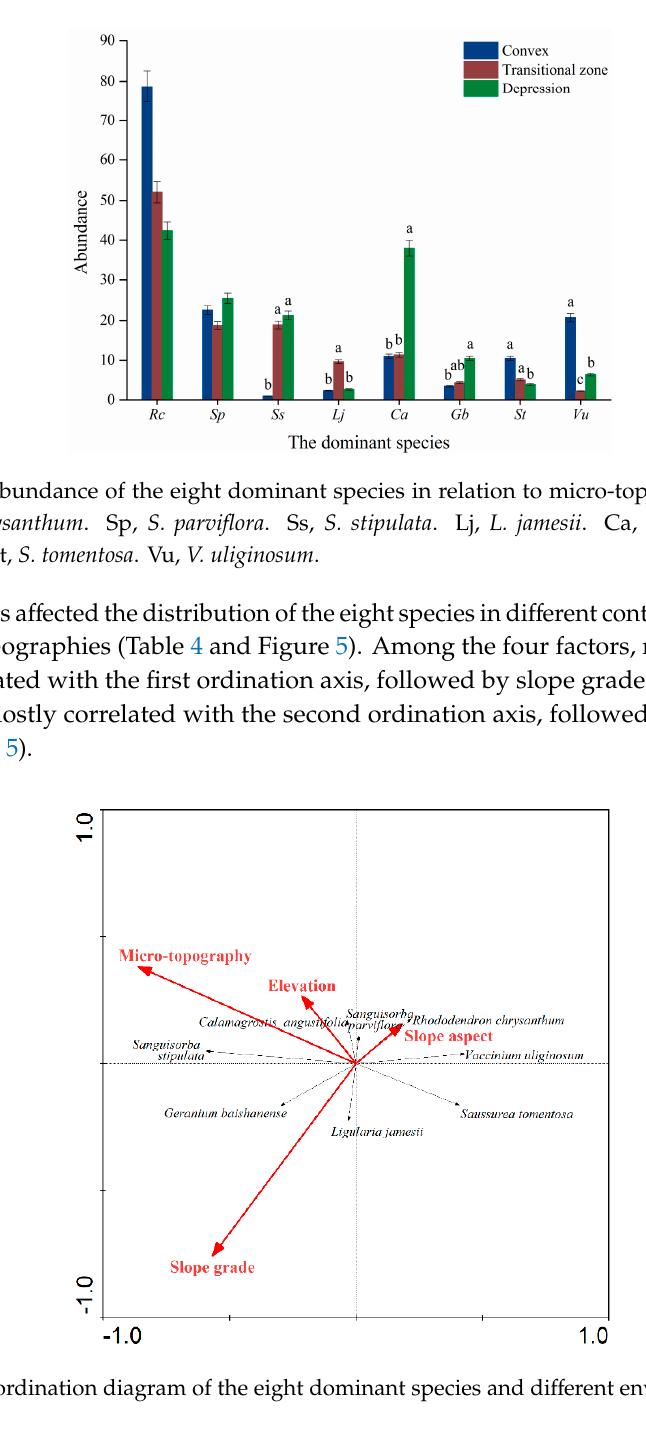
Figure 5. RDA ordination diagram of the eight dominant species and different environmental factors.